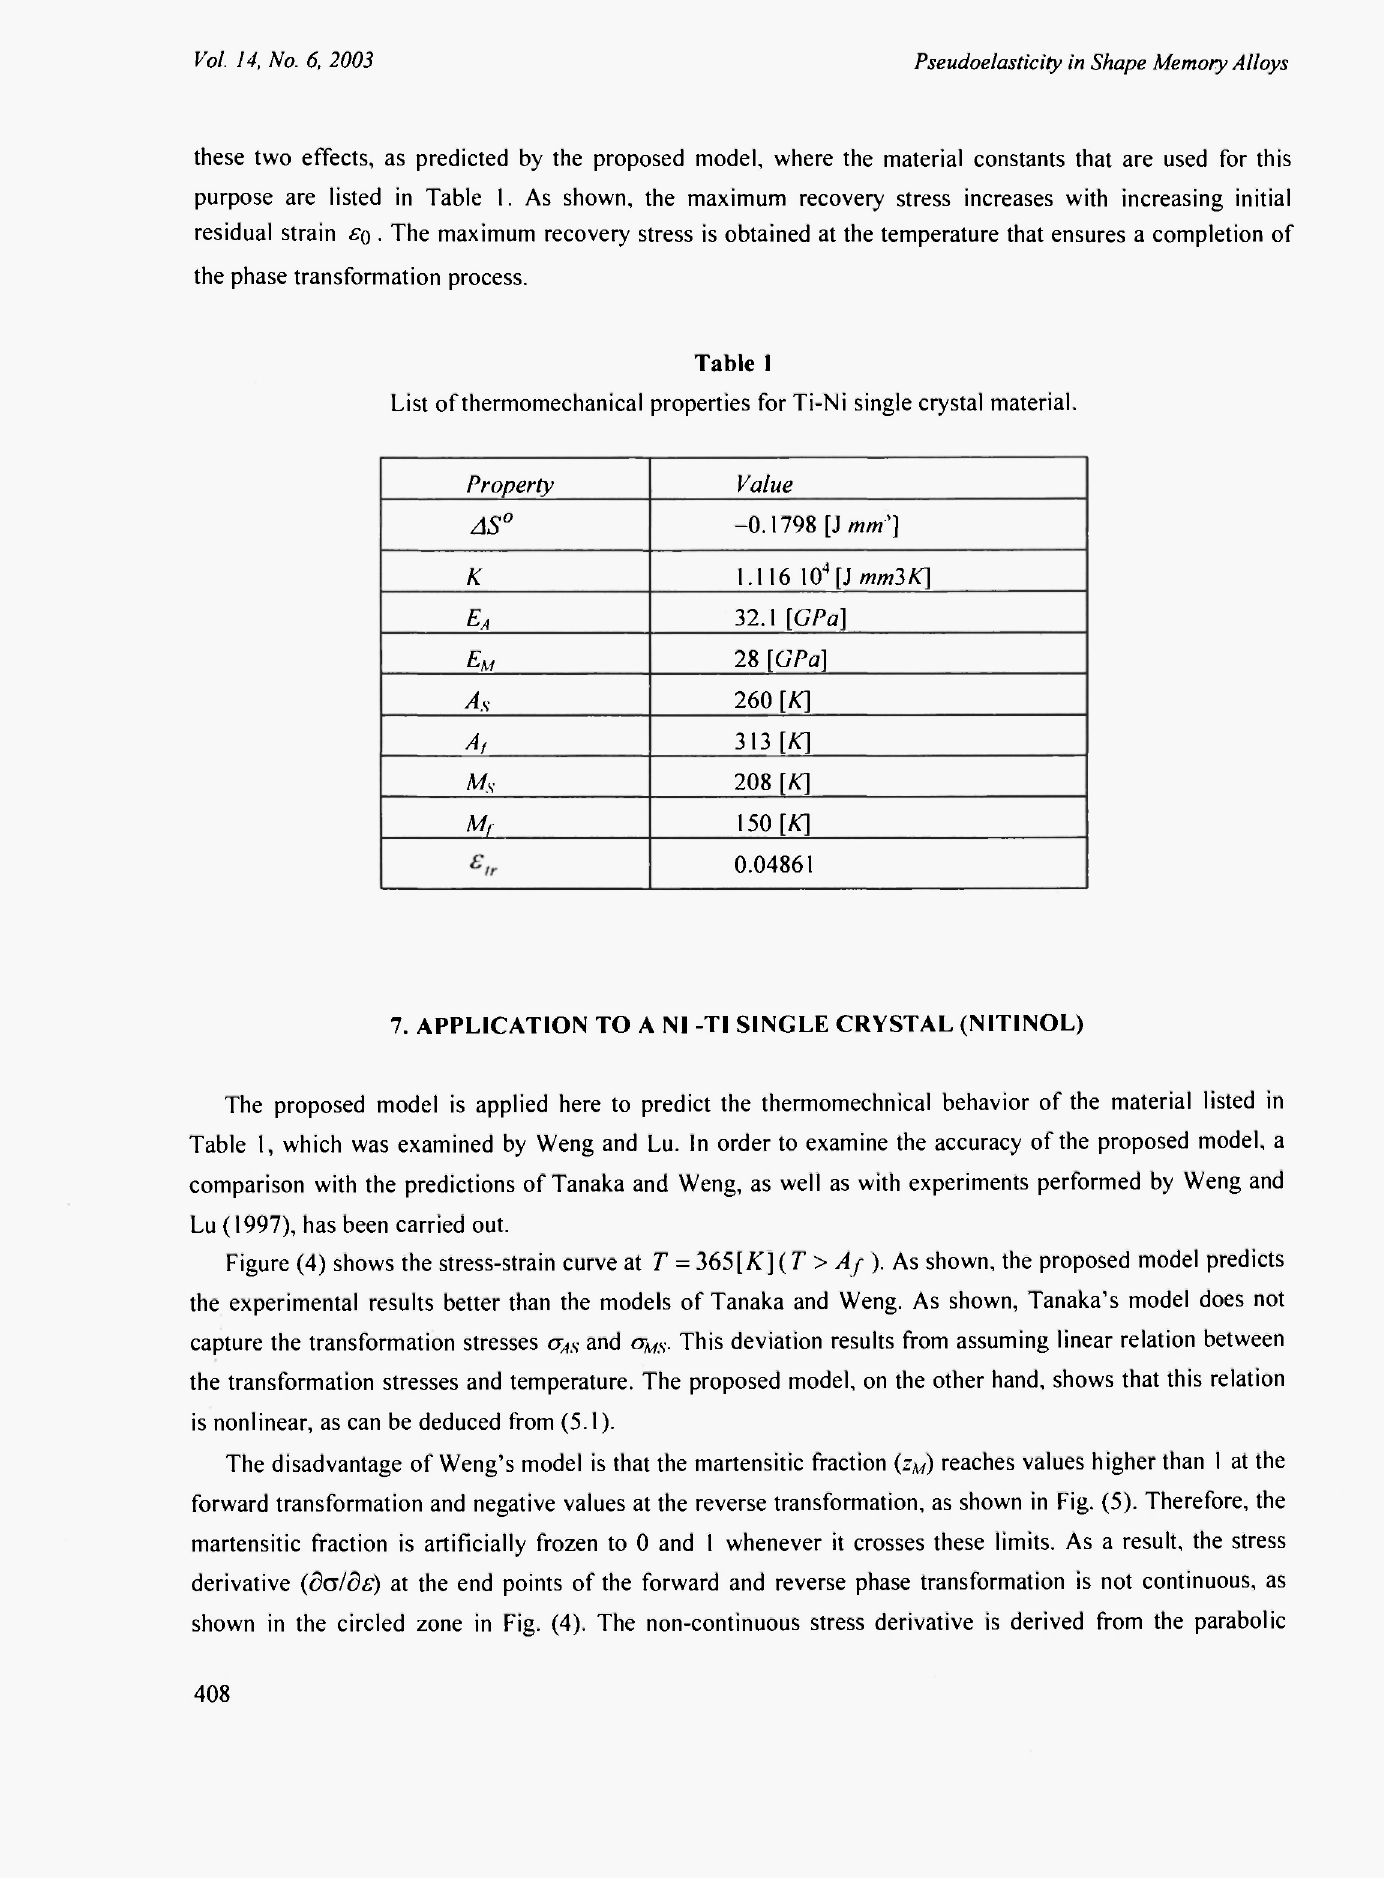
List of thermomechanical properties for Ti-Ni single crystal